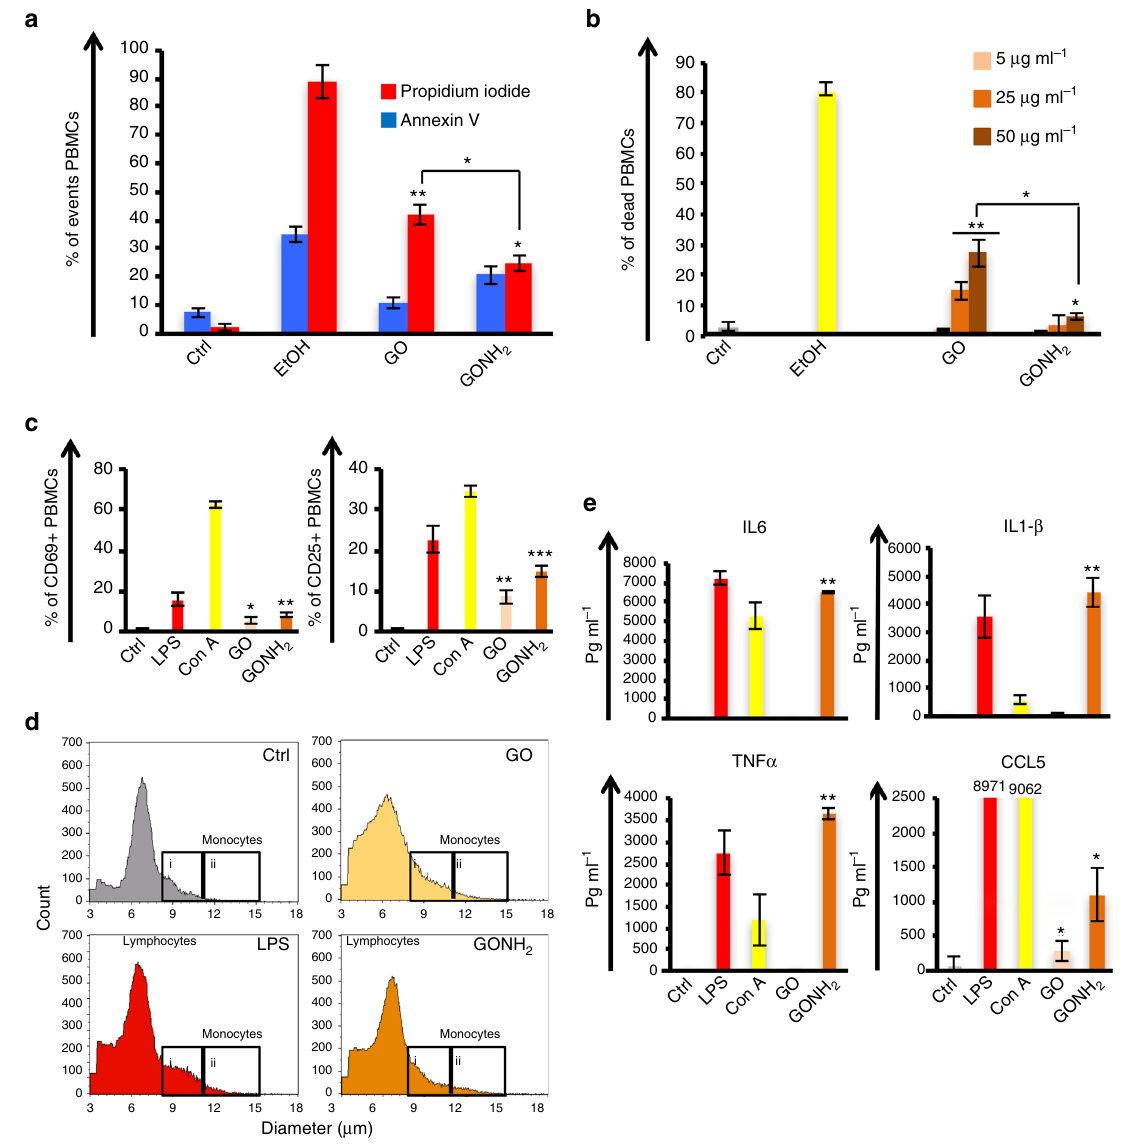
Fig. 5 Standard cell viability and activation assays in ex vivo PBMCs. PBMCs were incubated with GO and GONH 2 at increasing doses (5, 25, and 50 µ g ml − 1 ) and at a fi xed dose (50 µ g ml − 1 ) or left untreated (Ctrl). Data were analyzed using different stainings by fl ow cytometry. a Necrosis